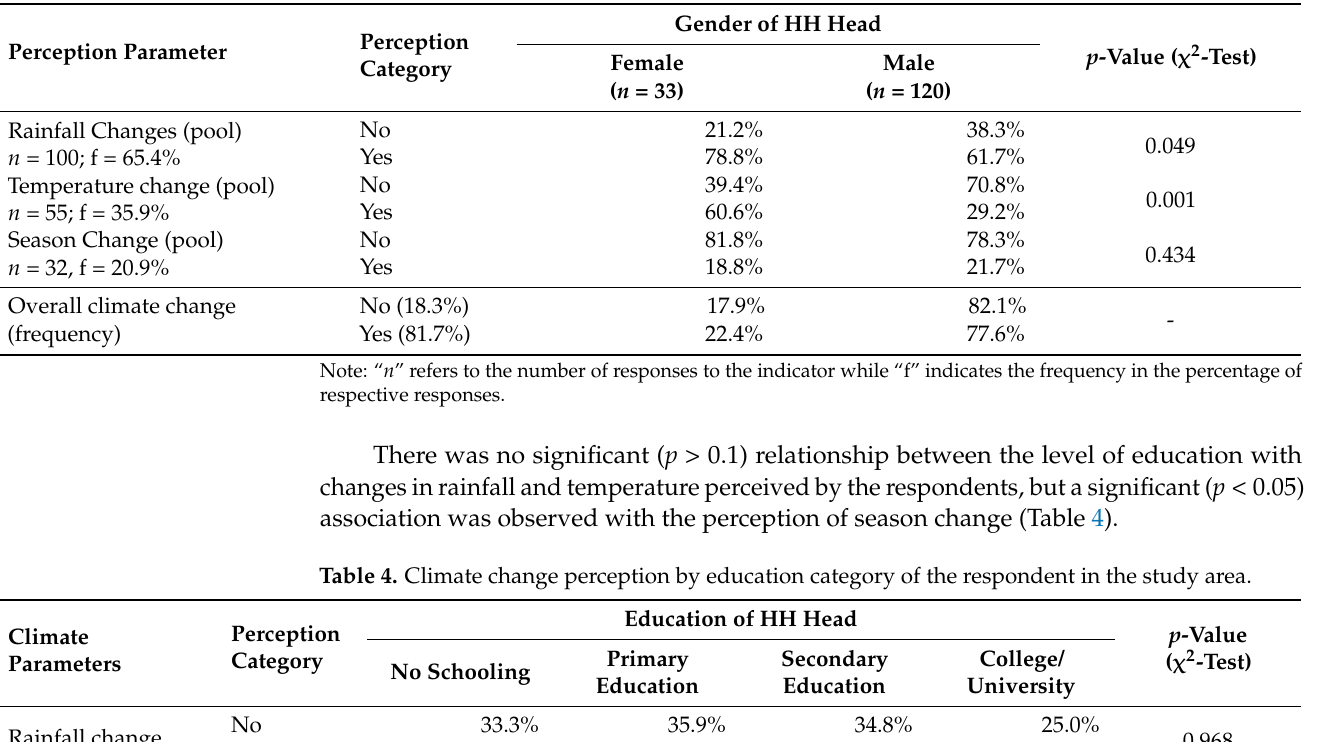
Table 3. Climate change perception by gender of the respondent in the study area.